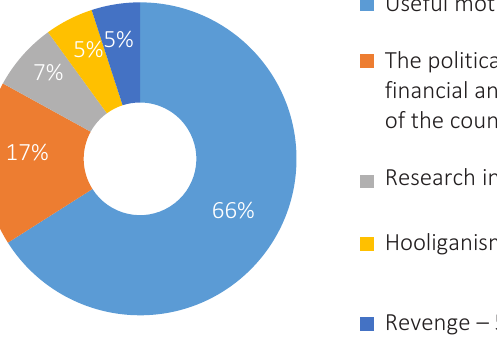
Figure 3. Information about the motives for committing computer crimes